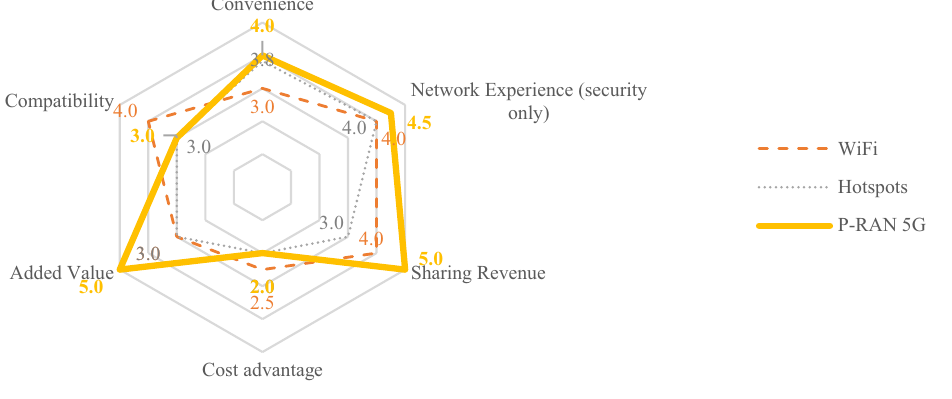
Figure 3. Results of value proposition evaluation of